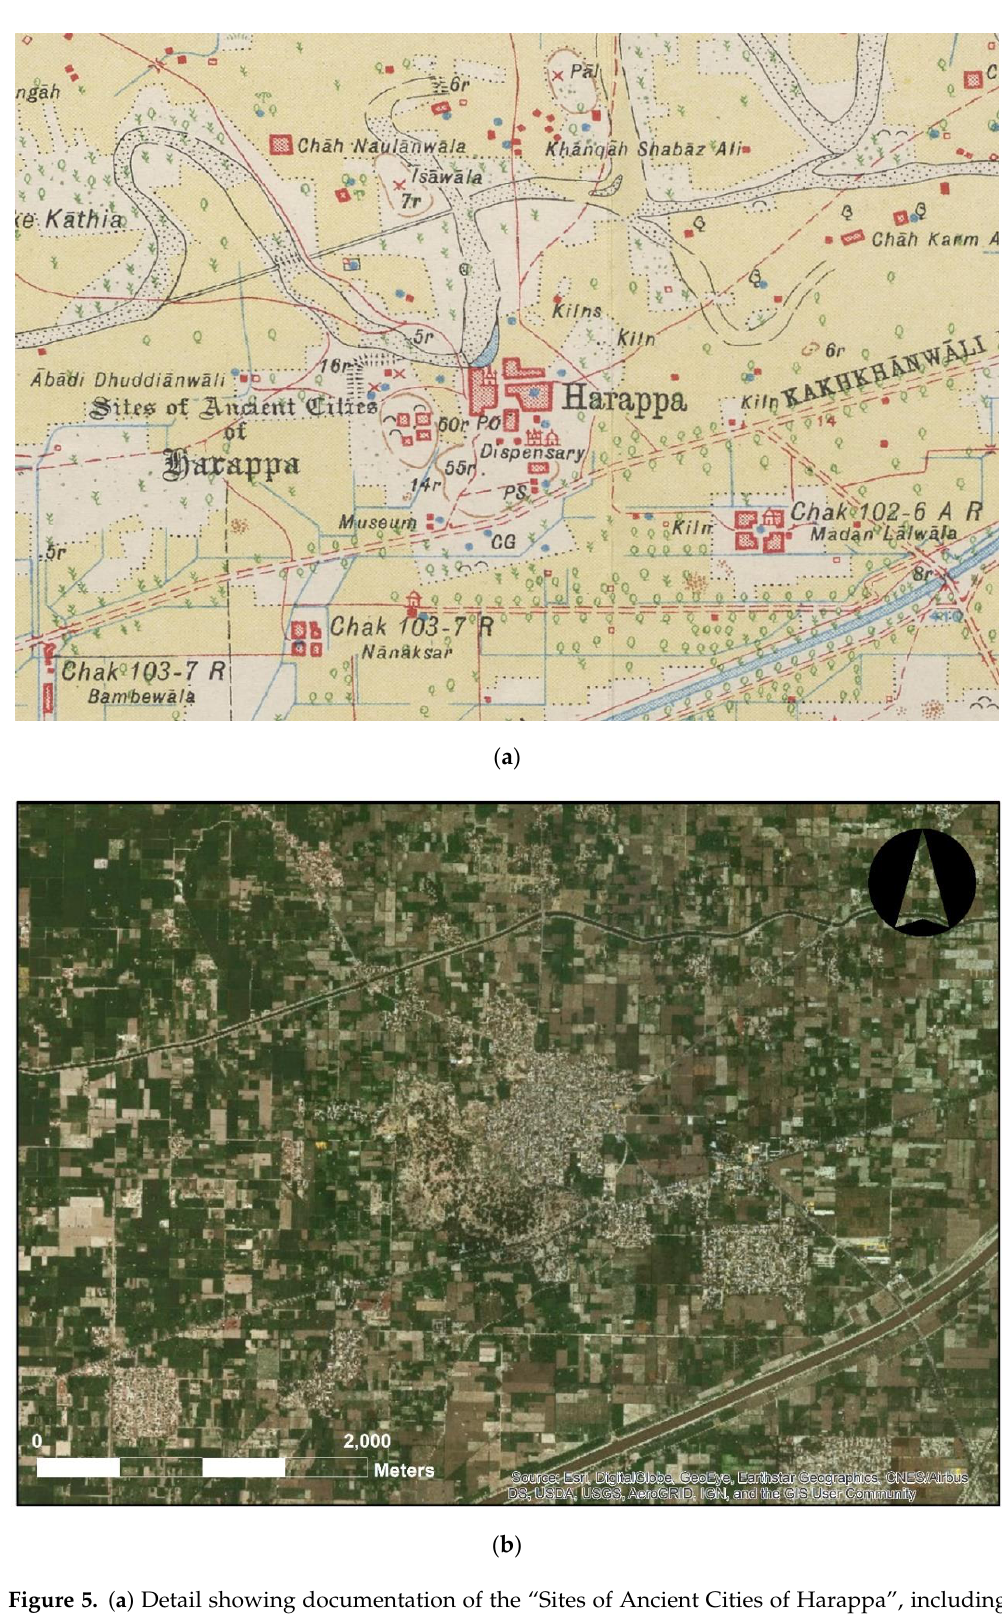
Figure 5. ( a ) Detail showing documentation of the “Sites of Ancient Cities of Harappa”, including depiction of mounds delineated by ‘form-lines’, graves, and ‘x’ signifying deserted villages, and their relationship to the modern town (44/B14/1933) (Image courtesy of Cambridge University Library); ( b ) ESRI world imagery of the same region today.